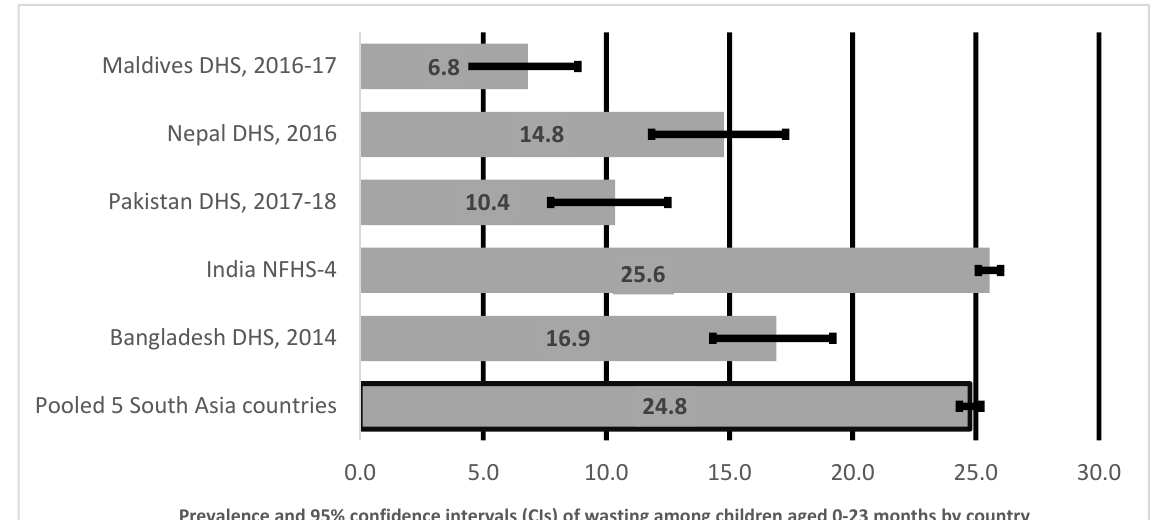
Figure 1. Prevalence and 95% confidence intervals (CIs) of wasting in children aged 0–23 months in South Asia.